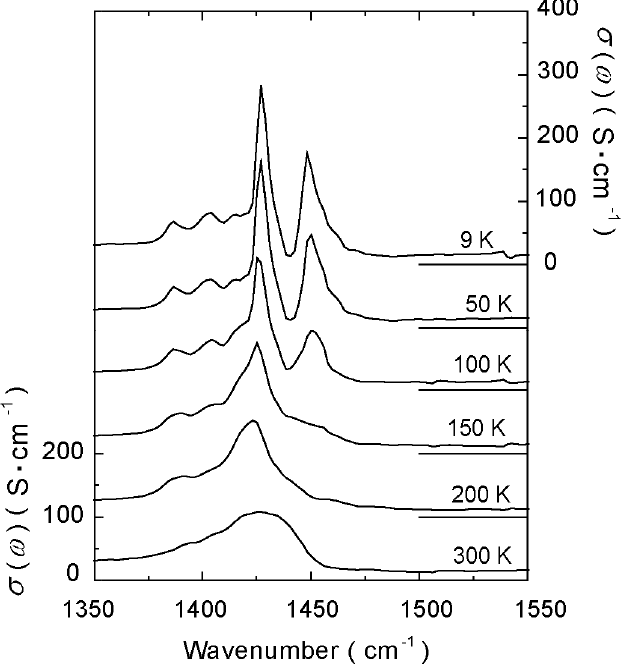
Figure 12. Temperature dependence of the β ″ -(ET) Cl ·2H O. The spectra are obtained after 3 2 2 IR-reflectance spectra.